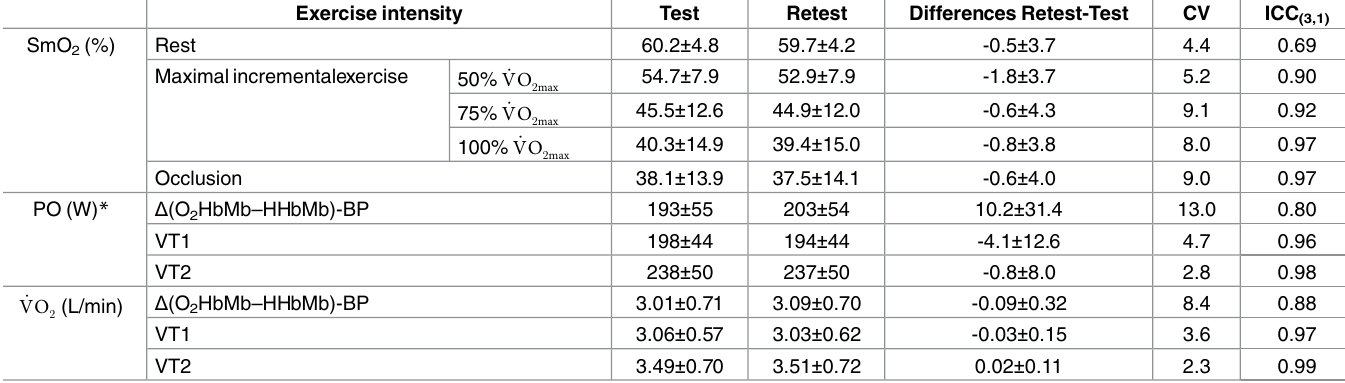
at the exercise thresholds 2